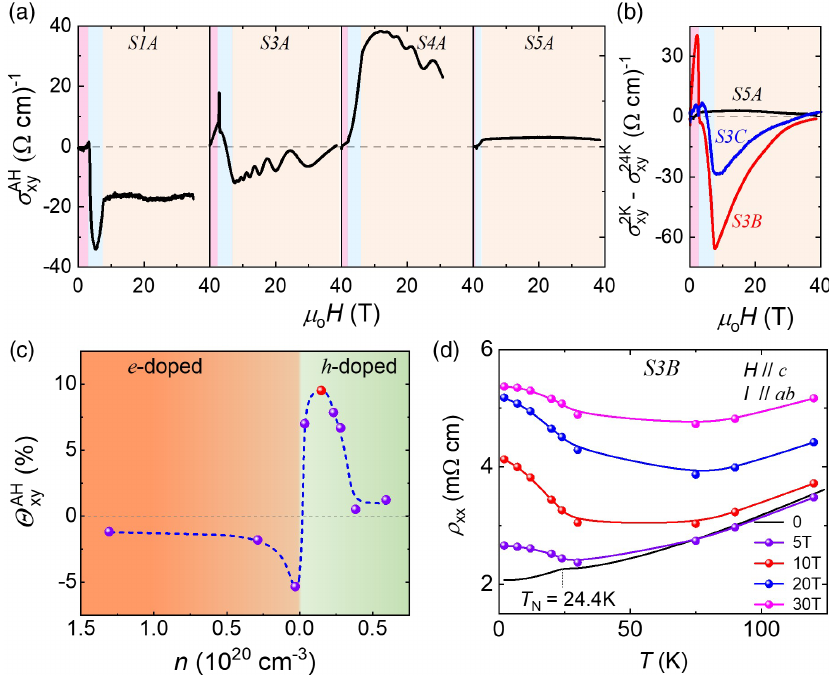
FIG. 4. Anomalous Hall effect in Mn ð Bi 1 − x Sb x Þ 2 Te 4 . (a) Field dependence of anomalous Hall conductivity σ AH xy for samples S1A , S3A , S4A , and S5A at 2 and 0.7 K. σ AH xy is derived using σ AH xy ¼ ρ AH yx = ½ ρ 2 xx þ ρ 2 yx (cid:2) , where ρ AH yx is the anomalous Hall resistivity, obtained after H Þ (see Sec. III). (b) Field dependence of σ 2 K subtracting the normal Hall contribution ð ρ N yx ¼ R H σ ρ = ð ρ 2 ρ 2 σ 24 K xy ¼ yx xy are extracted using xx þ yx Þ at 2 and 24 K, respectively. (c) The maximal anomalous Hall angle the FM phase as a function of the carrier density, obtained from the field dependence of Θ AH xy shown in Supplemental Material, Fig. S3 [48]. All data points are obtained at 2 K, except for S4A (0.7 K, red circle). (d) Temperature dependence of longitudinal resistivity ρ xx for S3B at various fields (applied along the c